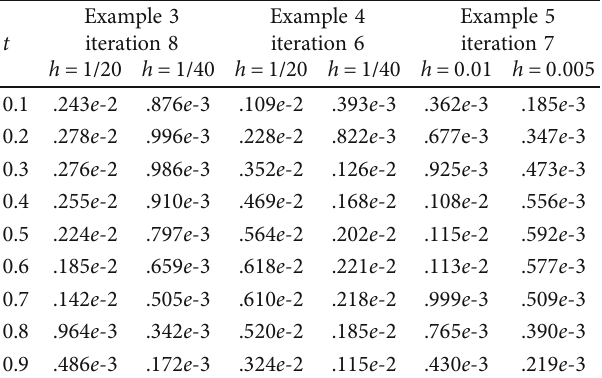
Table 1: Absolute error for the numerical solutions of Examples 3 – 5.